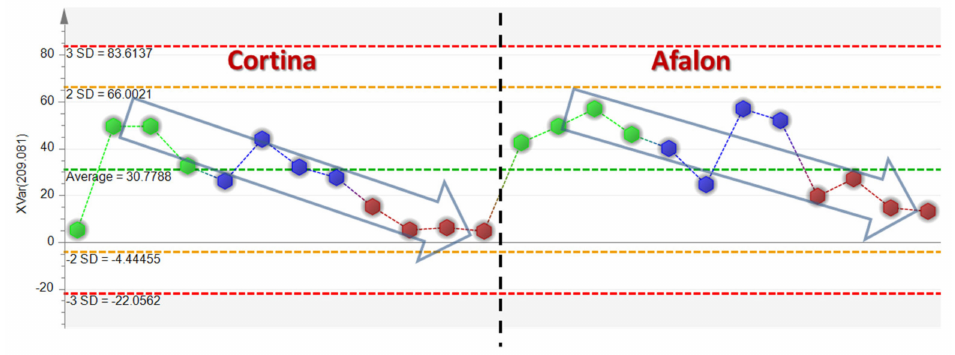
Figure 5. Differences in signal intensities of 6-MM ( m / z = 209.081) in ethylacetate extracts in positive ion mode (organic system–green, integrated system–blue, and conventional